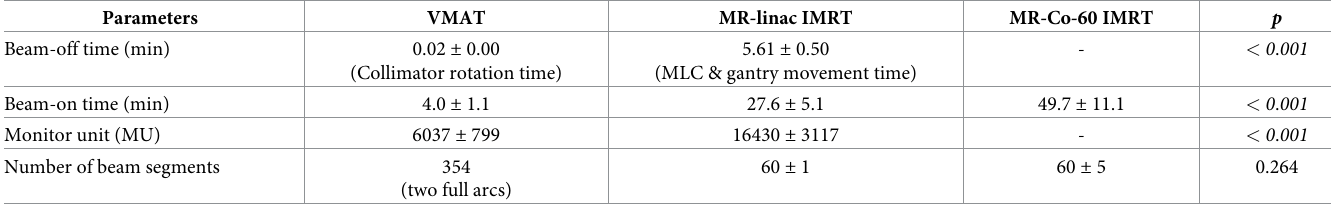
Table 1. Average treatment plan parameters.